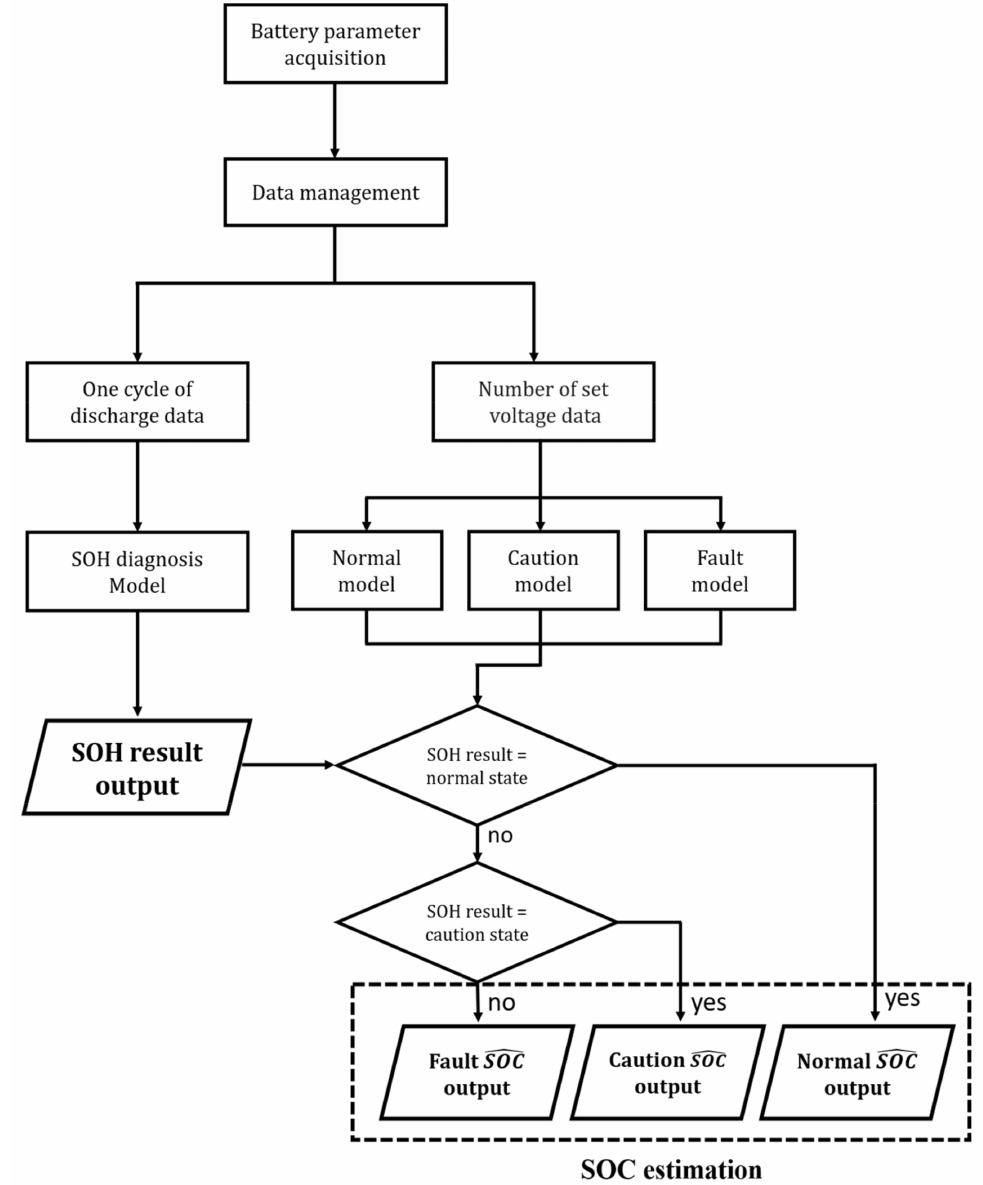
Figure 3. Flowchart of the proposed